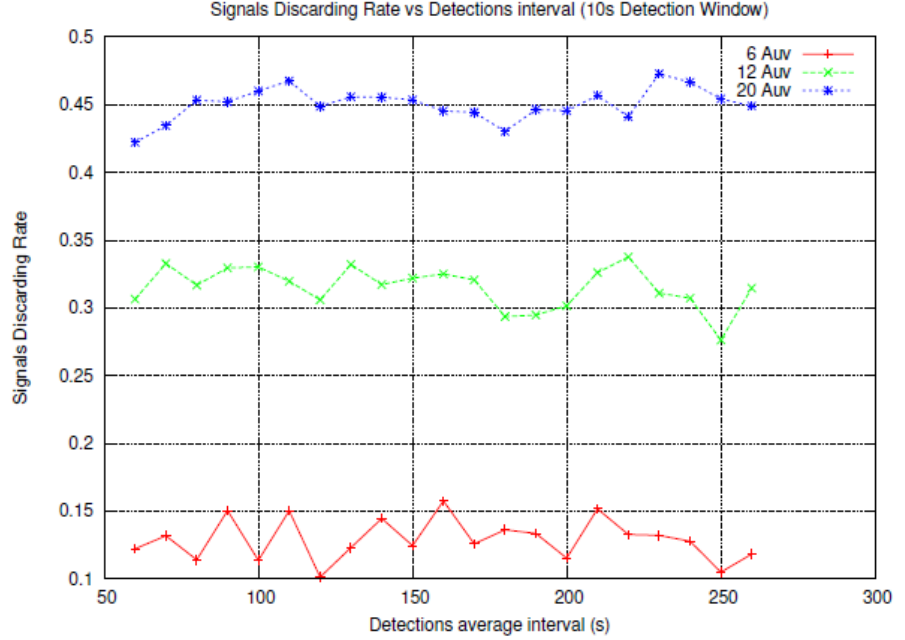
Figure 7. Signal Discarding Rate against detection interval, for different number of